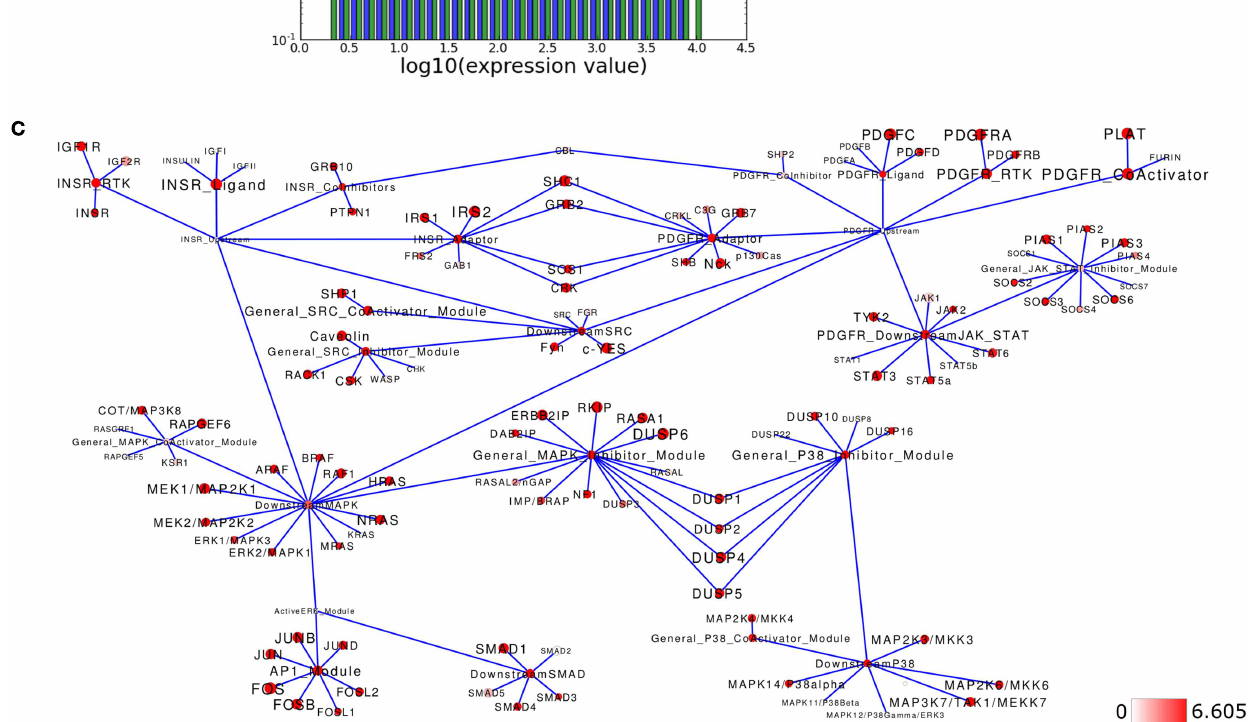
FIGURE 6 | Pathway activity analysis of the LMP ovarian cancer subcluster . (A) Regions of the heatmap in Figure 5 that appear to distinguish low malignancy potential (LMP) samples from all other ovarian cancer samples. (B) Plot showing distribution of log10 values of all network module activity values (blue bars) for allTothill et al. (2008) ovarian cancer samples versus log10 distribution of gene-expression values (green bars) of all genes